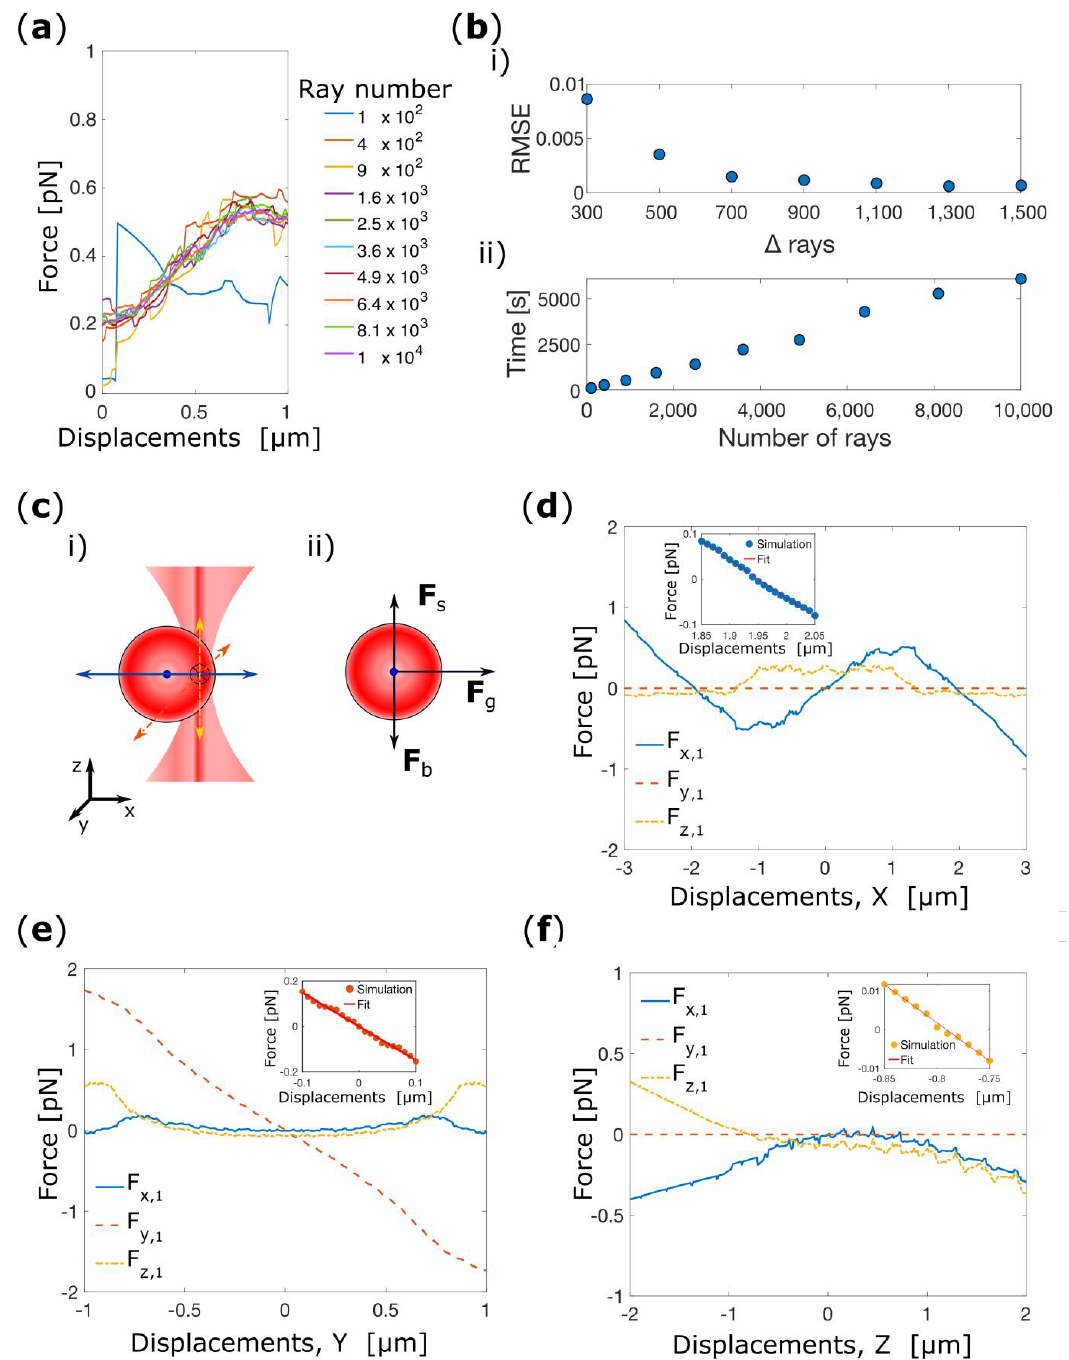
Figure 1. ( a ) Simulation of F tot ( x ) as a function of the number of light ray used in the simulation. ( b ) Residual mean squared error between F tot ( x ) calculated with an increasing number of light rays ( i ) and time required to simulate 601 points as a function of the number of light rays ( ii ). ( c ) Schematic depiction of the translation of the RBC ( i ) and respective free body diagram ( ii ) F g gradient force, F s scattering force and F b effective weight. Cartesian components of the total optical force acting on the center of mass of the RBC as a function of the cell’s displacements in respect to the center of the optical trap for displacements along x ( d ), y ( e ) and z ( f ). The laser beam power is kept constant at 5 mW for each simulation, and the cell is moved with steps of 10 nm along each direction. The inserts show the linear fit of the force-displacements curve near the equilibrium